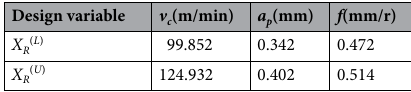
Table 6. Reliability stability